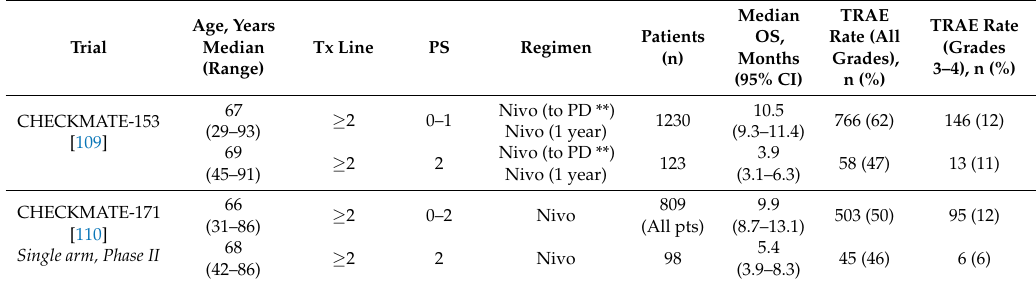
Table 6. Subgroup analyses of patients with ECOG PS 2 in trials of immune-checkpoint inhibitors in previously treated